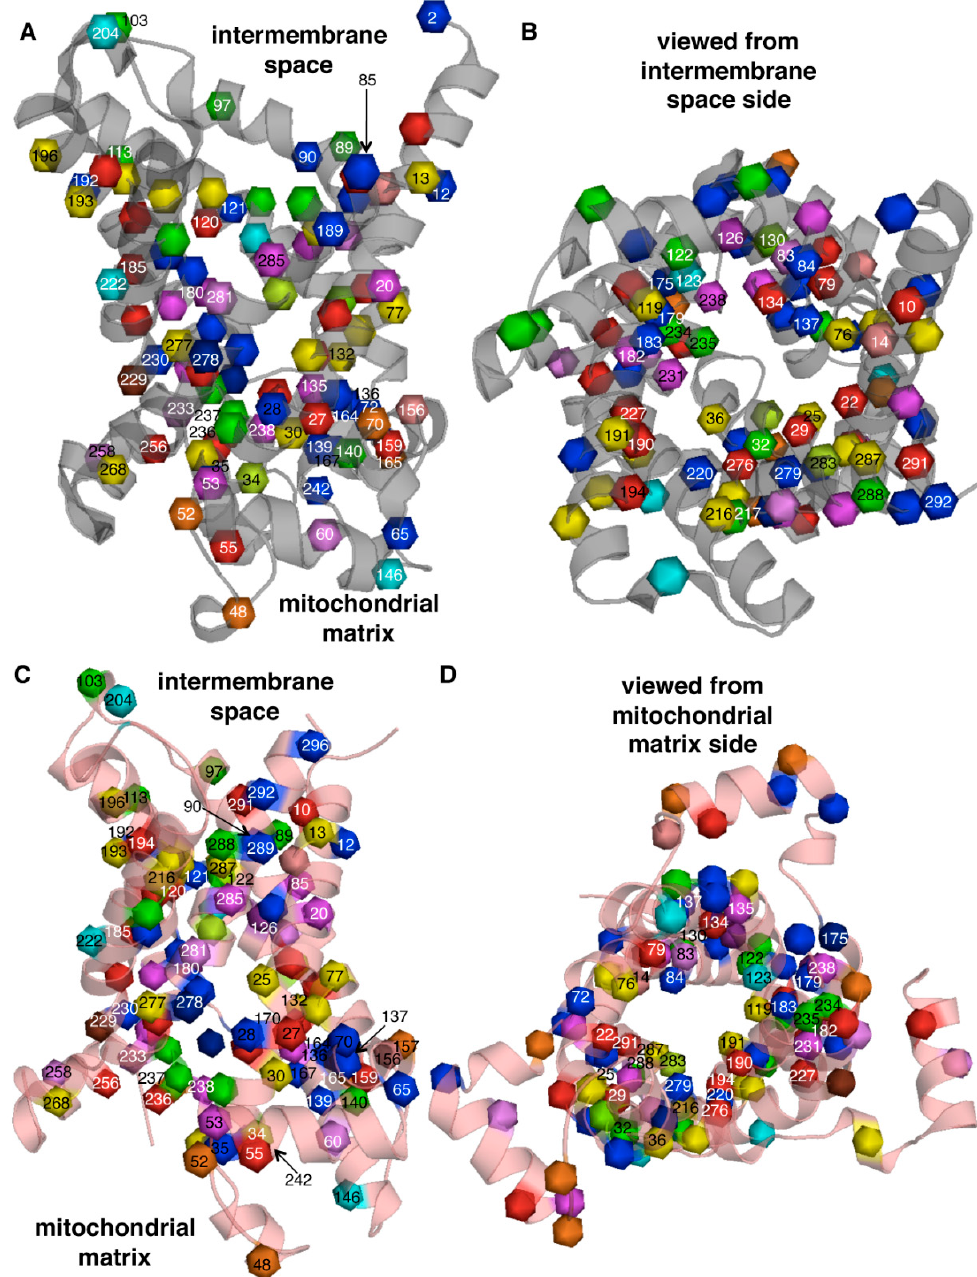
Figure 2. Structural positions of disease-causing point mutations in mitochondrial carriers. The bovine AAC1 structure (in the c-state, gray) and the thermophile AAC2 structure (in the m-state, pink) are viewed from the membrane plane ( A and C ) and the intermembrane space side ( B and D ). In all the panels, the α -carbons of the mutated positions are indicated as spheres colored as the top color of the mutations in the same position shown in the alignment of Figure 1. The numbering is that of bovine AAC1 (Figure 1) with the residue side chains exposed to the substrate translocation pore in B and D or outside the pore in A and C.